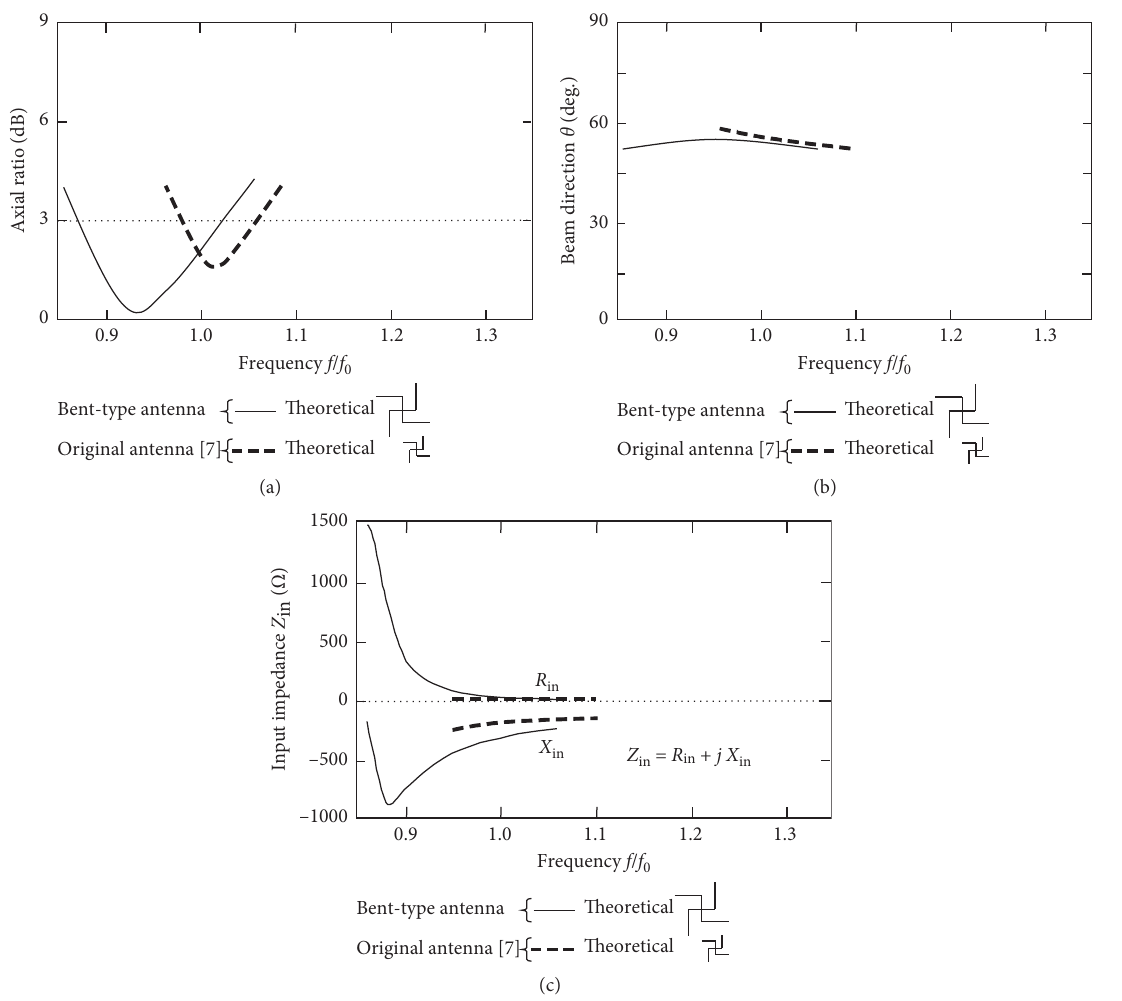
Figure 2: Frequency responses of axial ratio, beam direction, and input impedance of bent-type antenna for ( d together with those of the original antenna [7]. (a) Axial ratio. (b) Beam direction. (c) Input impedance.